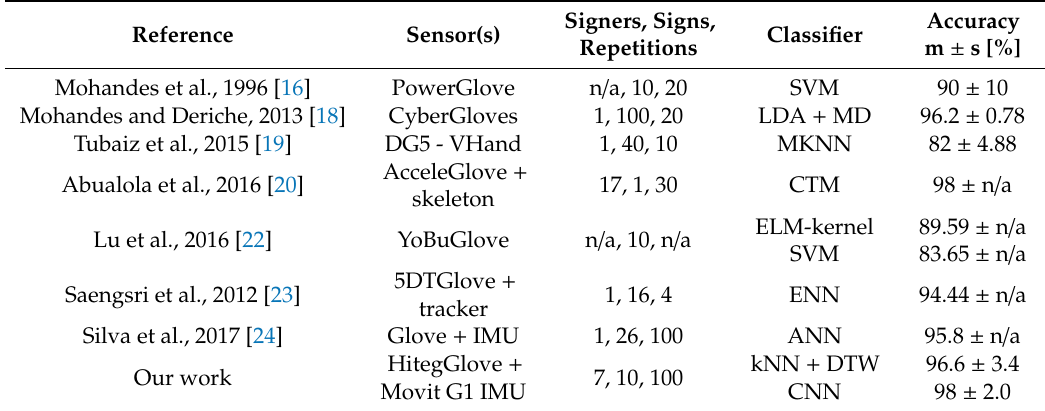
Table 3. Confusion matrix for the CNN classification